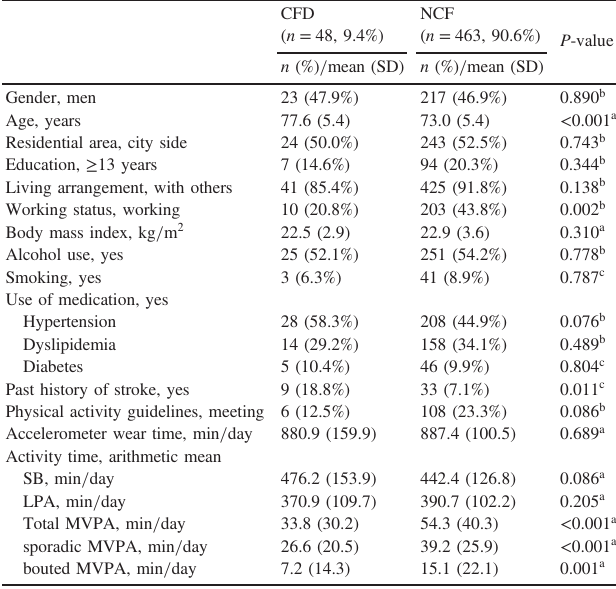
Table 1. Participant ’ s characteristics by cognitive status CFD